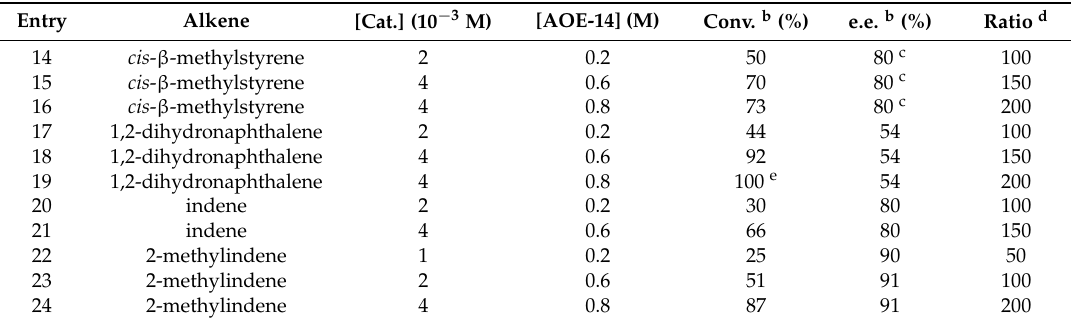
Table 3. Enantioselective epoxidation of alkenes with H 2 O 2 catalysed by (salen)Mn(III) in H 2 O in the presence of AEO-14 as surfactant at 25 ˝ C.